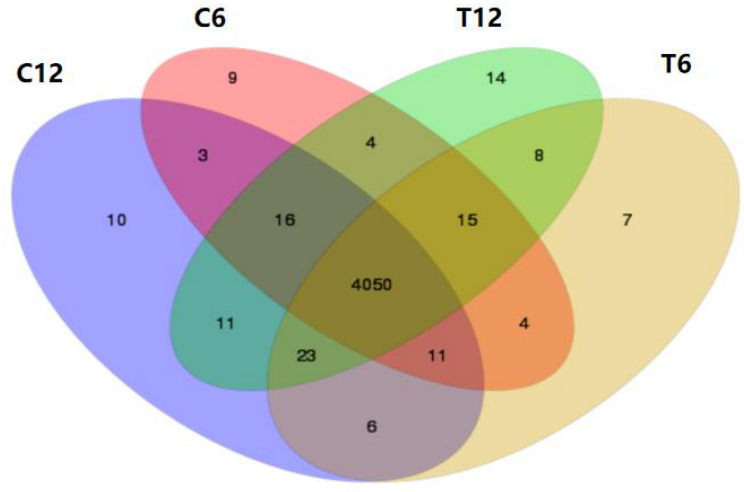
Figure 1. Venn diagram of shared genes between samples.